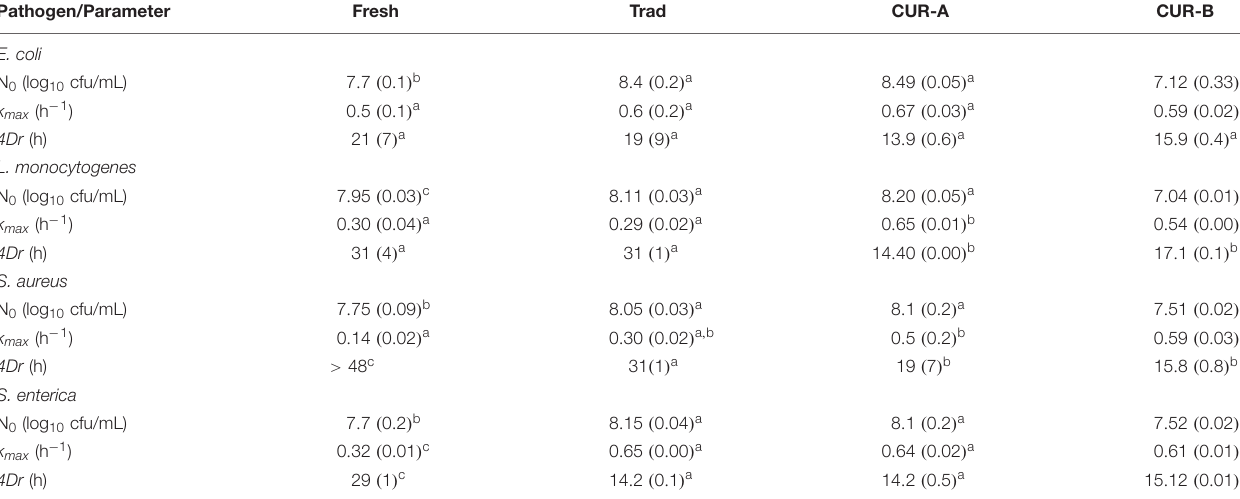
FIGURE 1 | Fit of the log-linear regression model to the survival data of the S. aureus cocktail in the 3 commercial presentations. Trad, traditional Aloreña de Málaga presentation; Fresh, fresh green presentation; CUR-A and CUR-B refer to the two industries which elaborated the cured presentations. TABLE 2 | Parameters obtained using a Log-linear regression model (Bigelow and Esty, 1920) implemented in GinaFit to the survival data of the foodborne pathogen cocktails in the Aloreña de Málaga commercial packaging. Pathogen/Parameter Fresh Trad CUR-A